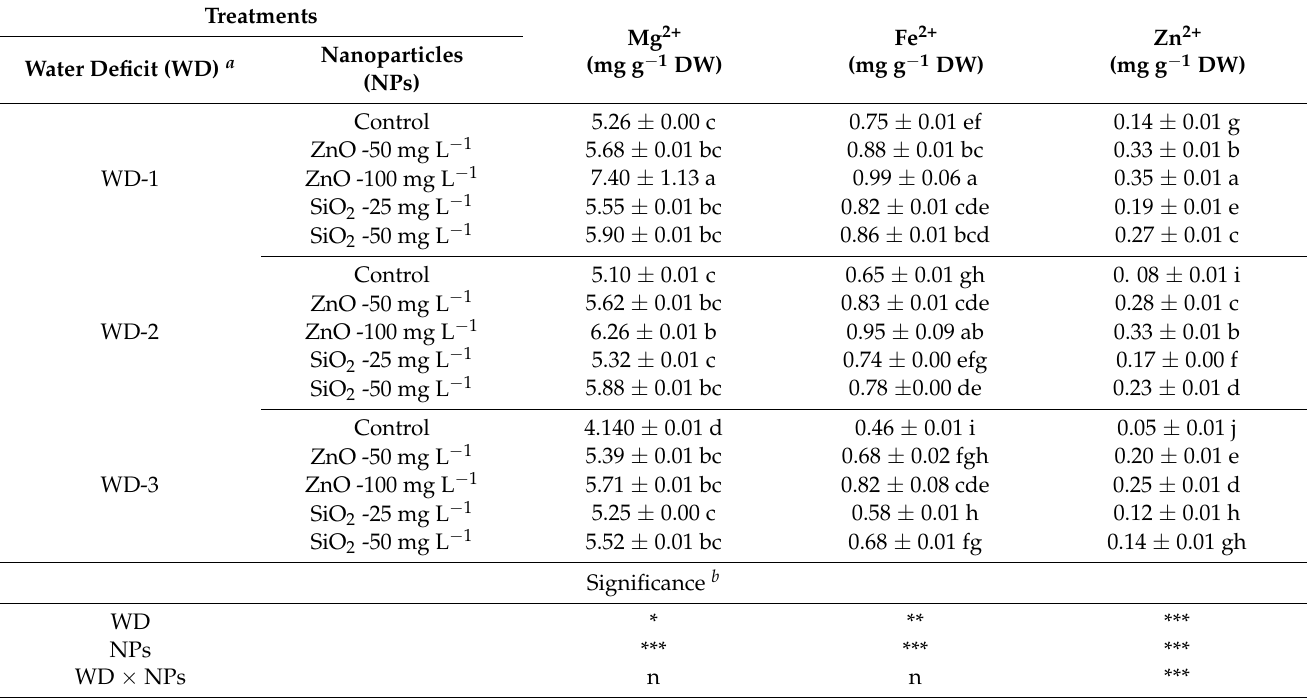
Table 6. Influence of foliar nanoparticles (NPs) on magnesium, iron, and zinc in potato tubers grown under different water deficit conditions (irrigation